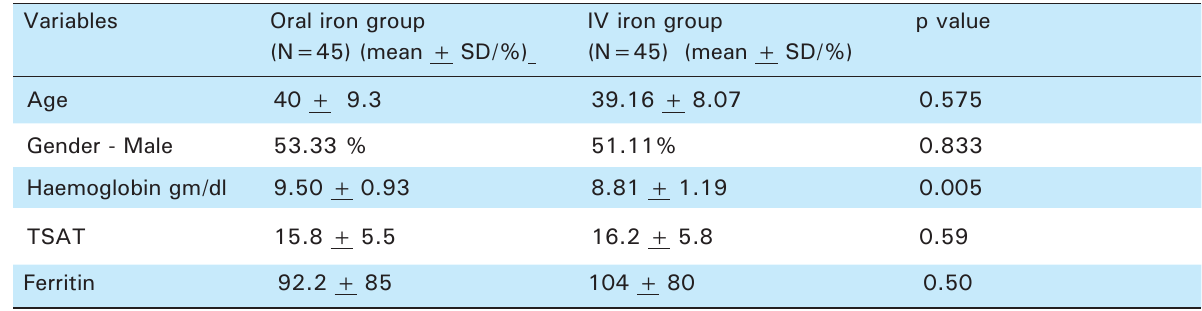
Table 1. Baseline characteristics of